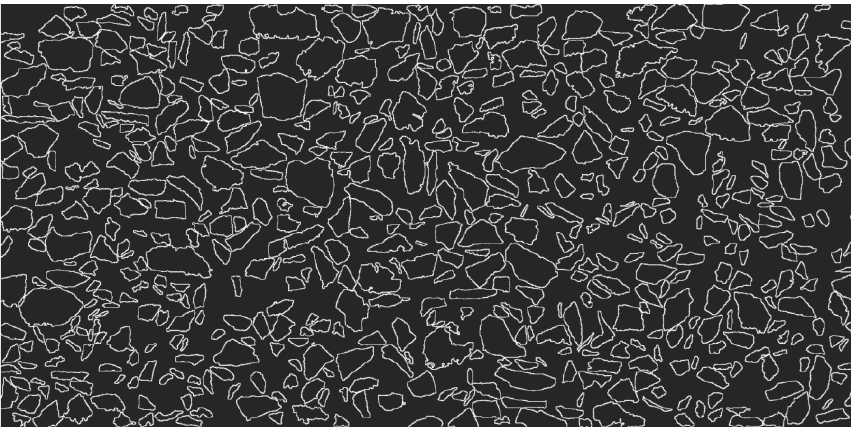
Figure 4. Framework of the asphalt mixture.